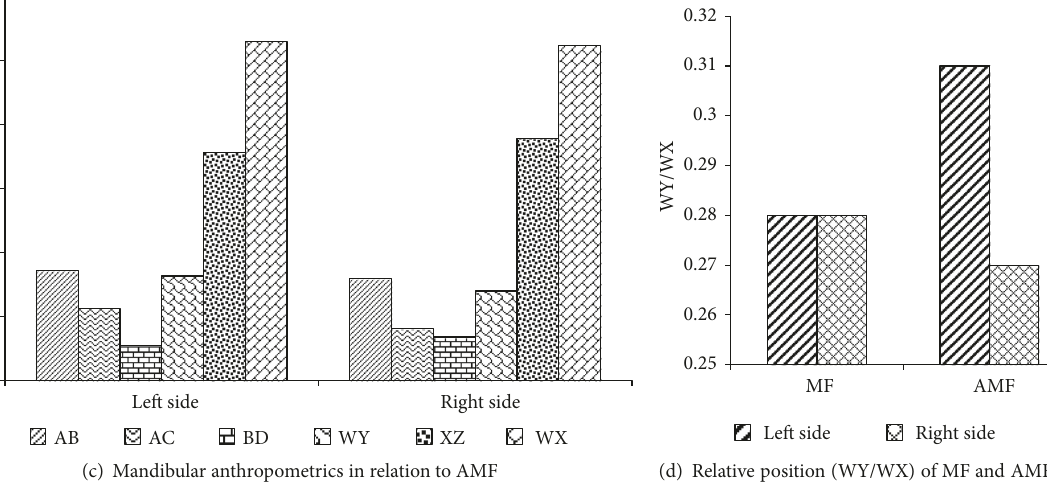
Figure 5: Mandibular anthropometric measurements on Zambian adult human mandibles (n=33). AB: alveolar crest, lower border of mandible; AC: alveolar crest, upper margin of foramen; BD: lower border mandible, lower margin foramen; WY: symphysis menti, medial margin of foramen; XZ: posterior border ramus, lateral margin foramen; WX: length of mandibles; WY/WX: relative position. The error bars represent the standard deviation of